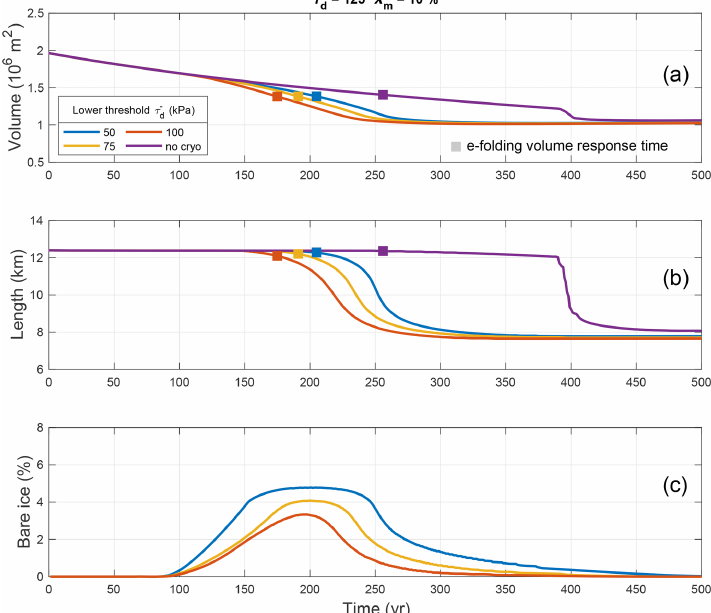
Figure B2. Sensitivity of model to different lower threshold values τ − length response, and (c) bare ice equivalent debris-covered area during a retreat after a 100m step change in ELA from 3000 to 3100m. In all cases, the debris concentration is c = 0 . 25%, the upper driving stress threshold is τ + λ m =